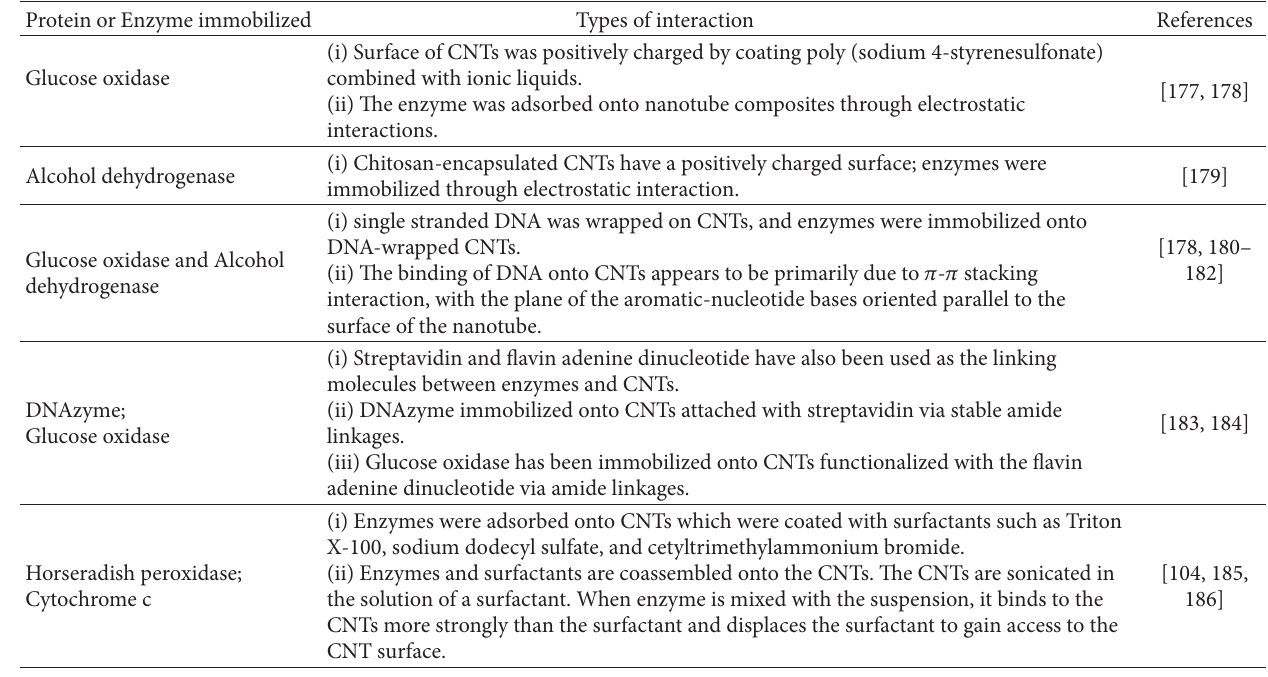
T 6: Noncovalent immobilization of protein and enzymes by indirect speci�c adsorption.